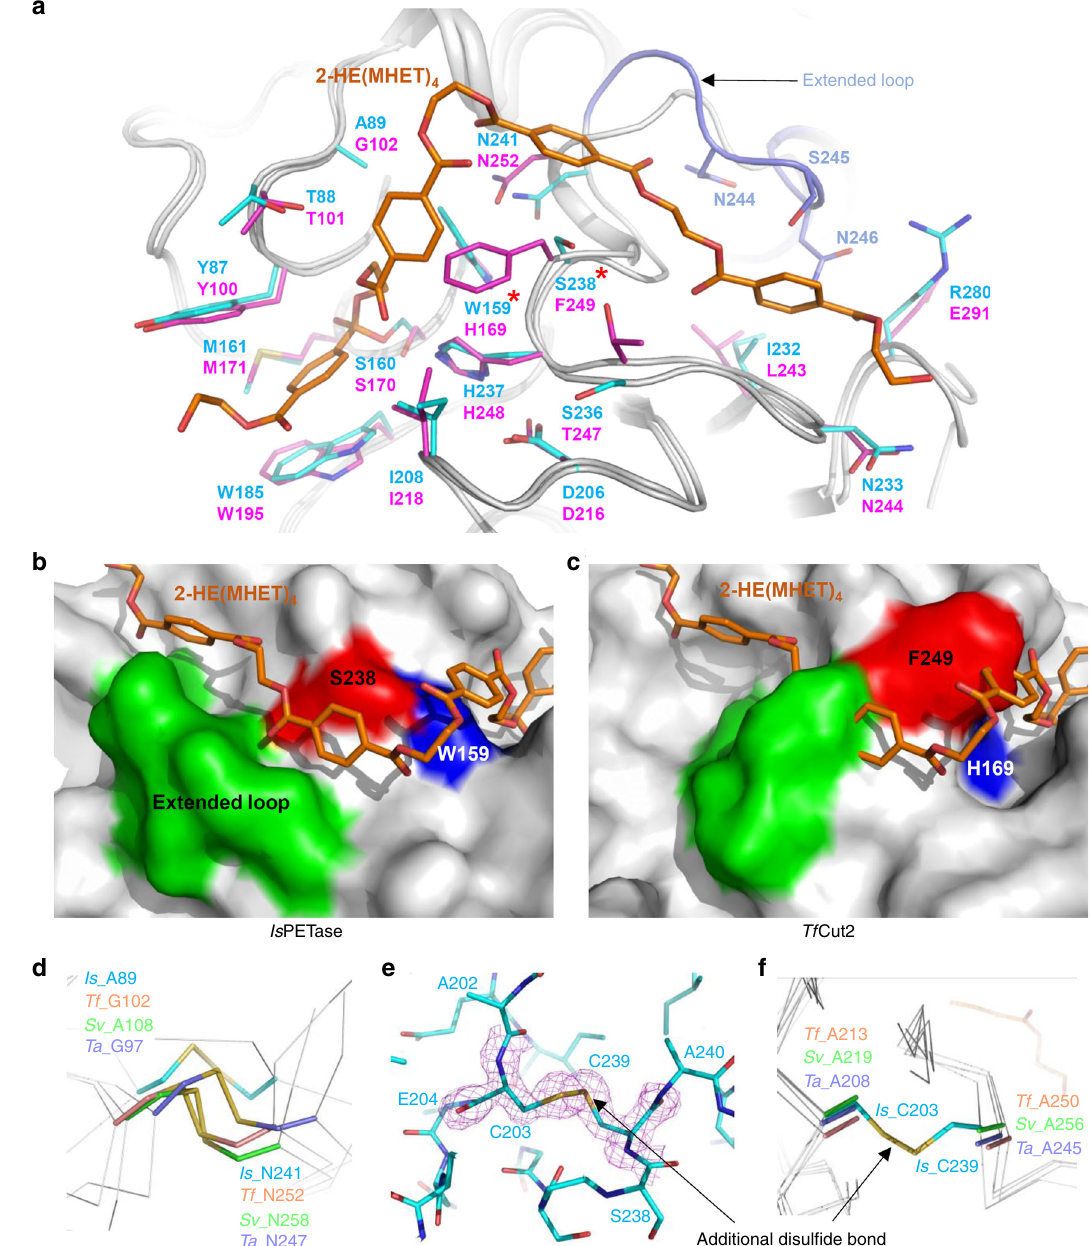
Fig. 5 Structural comparison of PET-degrading enzymes. a Superposition of the structures of Is PETase and Tf Cut2. Both structures of Is PETase and Tf Cut2 are shown as gray-colored cartoon model. The 2-HE(MHET) 4 docking model of Is PETase is shown as an orange-colored stick. Residues constituting subsite I and subsite II of Is PETase and Tf Cut2 are shown as a line models with cyan and magenta colors, respectively, and labeled. The unique residues observed in Is PETase, Trp159 and Ser238, are indicated with star marks. The extended loop of Is PETase distinguishable from Tf Cut2 is shown in light-blue color. b , c Structural difference on subsite II of Is PETase ( b ) and Tf Cut2 ( c ). The structures of Is PETase and Tf Cut2 enzymes are presented as surface models with a gray color. The 2-HE(MHET) 4 docking model of Is PETase is shown as an orange-colored stick. The Ser328 and Trp159 residues in subsite II and extended loop of Is PETase corresponding phenylalanine and histidine residues and extended loop in other PET-degrading enzymes are distinguished and labeled, respectively. d Disul fi de bond found in PET-degrading enzymes. The disul fi de bond found in each all four PET-degrading enzymes is shown as a stick model, respectively and the residues forming the disul fi de bond are labeled. e , f Additional disul fi de bond found in Is PETase. The Is PETase structure is presented as a stick model and the omit electron densities (magenta mesh) of the residues constituting the additional disul fi de bond in Is PETase are contoured at 2.0 σ ( e ). The additional disul fi de bond region in Is PETase is compared with the corresponding regions in other PET-degrading enzymes ( f ). The residues forming the additional disul fi de bond in Is PETase and those located at the corresponding positions in other PET-degrading enzymes are shown as a stick model and labeled